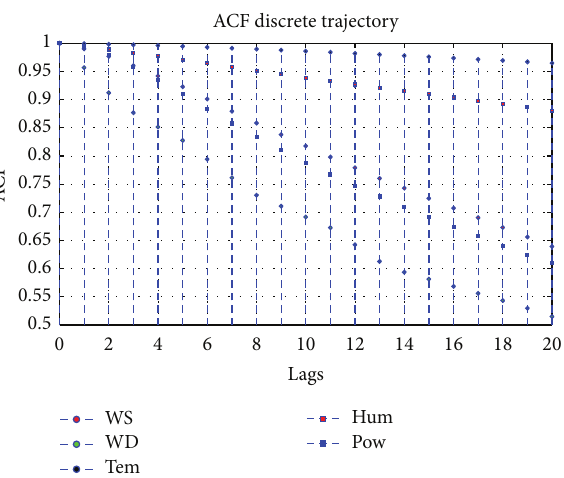
Figure 5: ACF discrete trajectory.